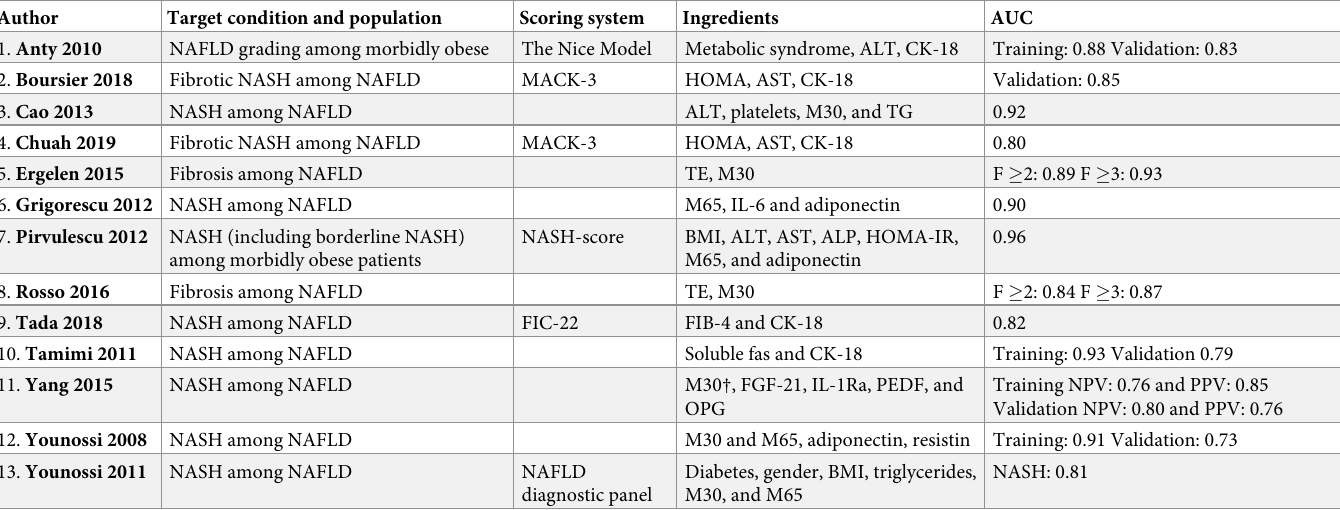
Table 4. Summary of studies that additionally included CK-18 in multimarker